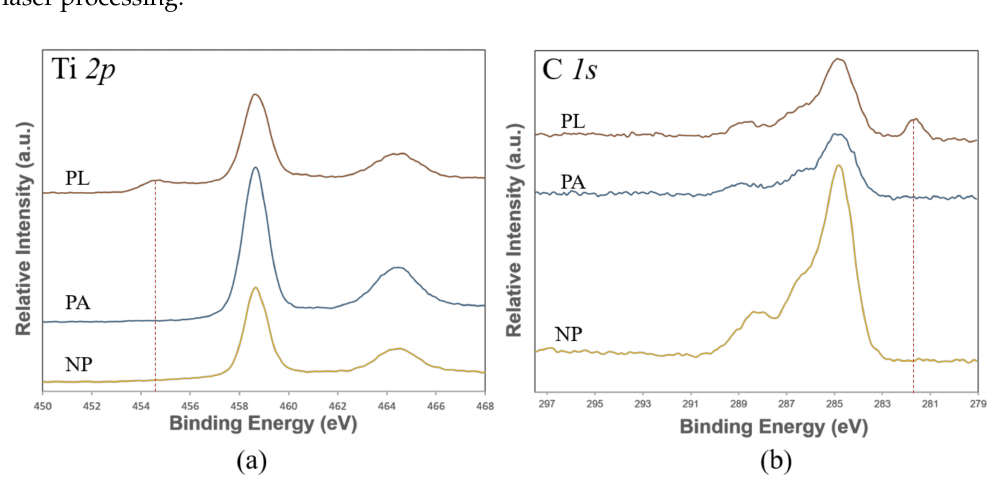
Figure 5. XPS spectra of Ti 2p ( a ) and C 1s ( b ) for sample underwent non-processing (NP), laser processing in air (PA) and in liquid